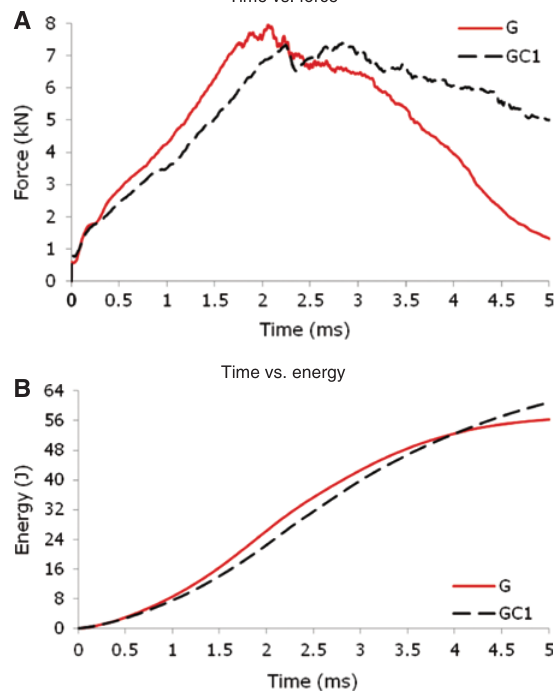
Figure 3: Time history plots of force and energy for the laminates with and without carbon fiber.